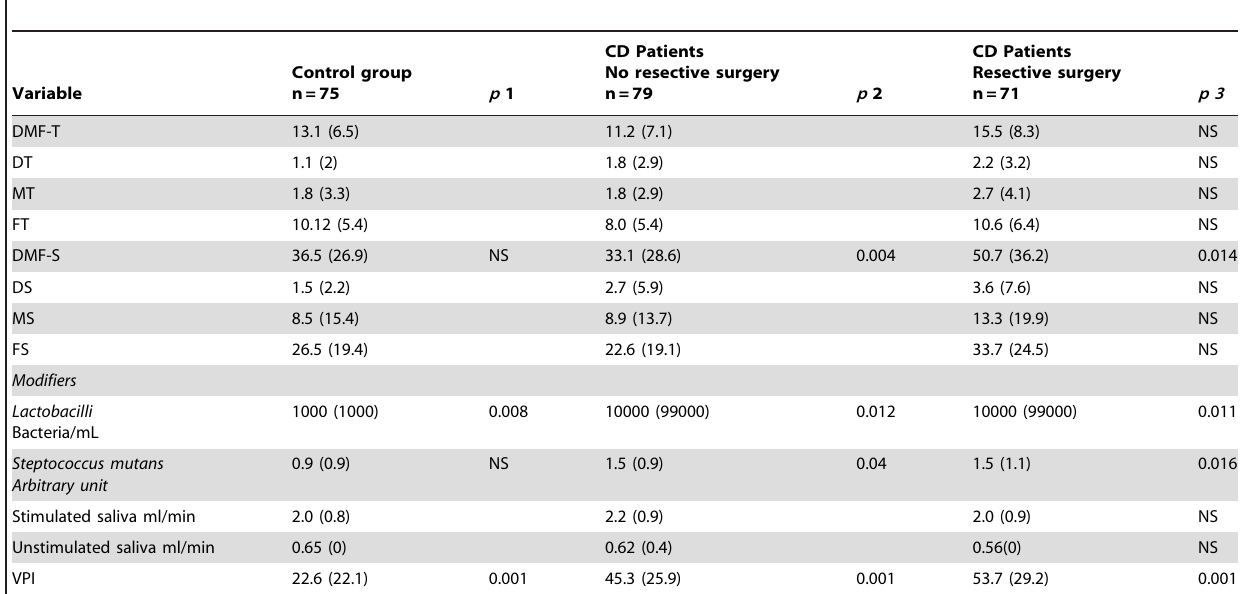
Table 2. Mean (SD) for the DMF-T/DMF-S index, Steptococcus mutans , volume of stimulated - and unstimulated saliva, the amount of dental plaque, and median (interquartile range) for Lactobacilli , in CD patients (who had not and had undergone resective surgery) and